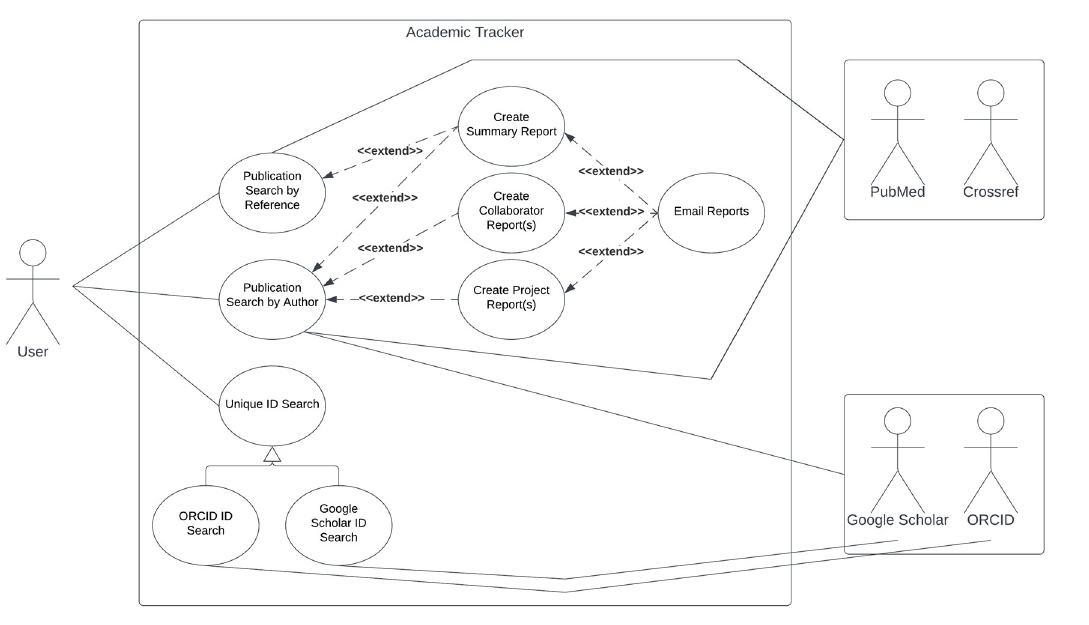
Fig 1. Academic Tracker use-case diagram. The first and third use-cases, publication search and collaborator search, are illustrated via the “Publication Search by Author” option. The second use-case, publication information, is illustrated via the “Publication Search by Reference” option. The supporting use-case, ORCID ID and Google Scholar ID searches, are illustrated by the “Unique ID Search” option.